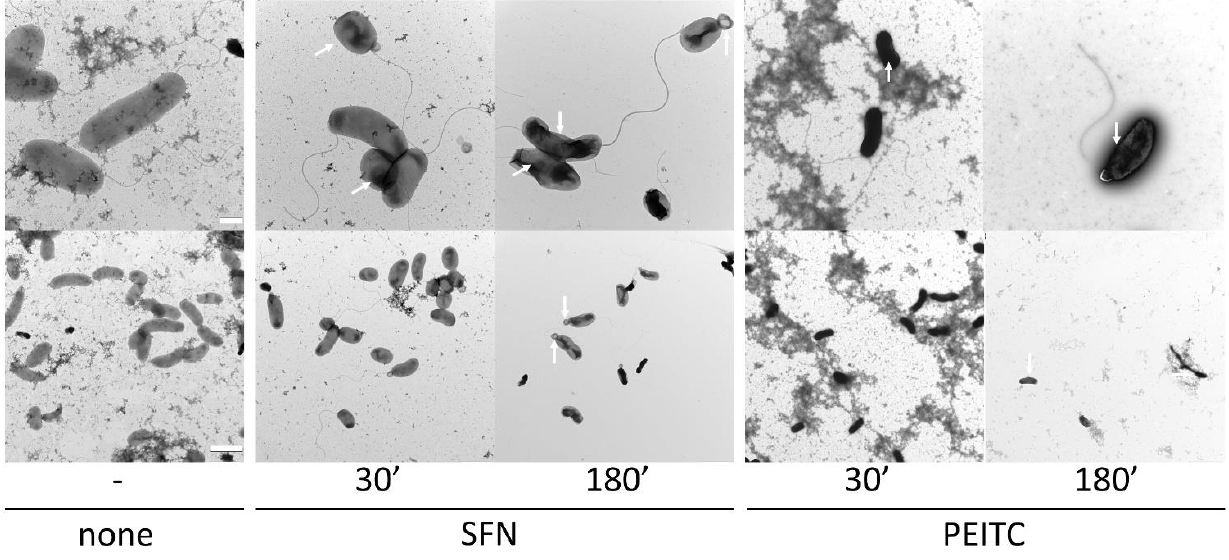
Figure 2. TEM analysis of morphological changes after ITC treatment. Cells treated with MIC of SFN or PEITC after different treatment times (30, 180 min) at 37 ◦ C, or none for control experiment. The white arrows indicate shape malformations and cytosol leakage. White bars indicate the scale: 0.5 µ m and 2 µ m for the upper panel and the bottom panel, respectively.